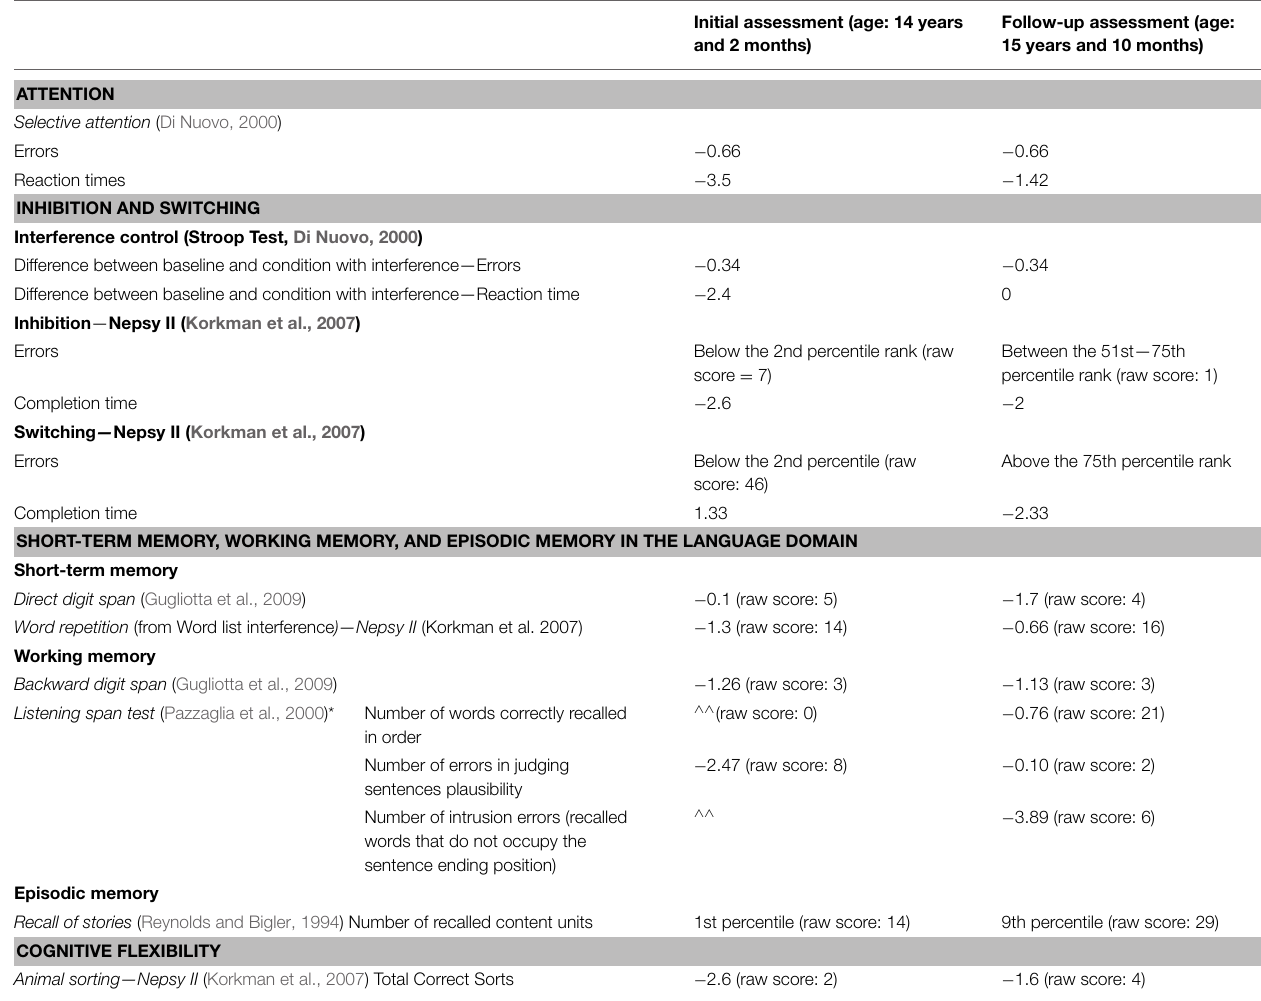
TABLE 5 | The initial and follow-up assessments analyzed with standard scores or percentile ranks (comparison with chronological age norms unless specified otherwise in the table).